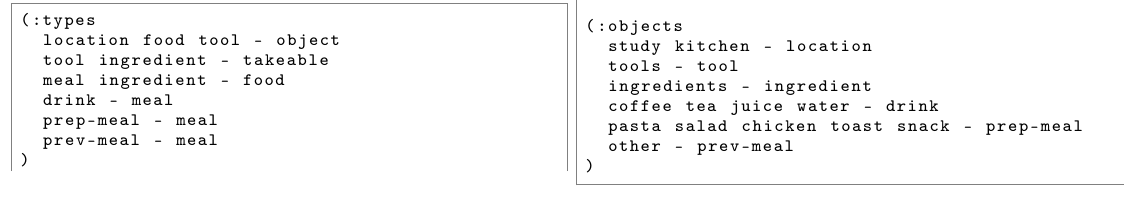
Figure 4. Example definition of types and their concrete objects for the cooking